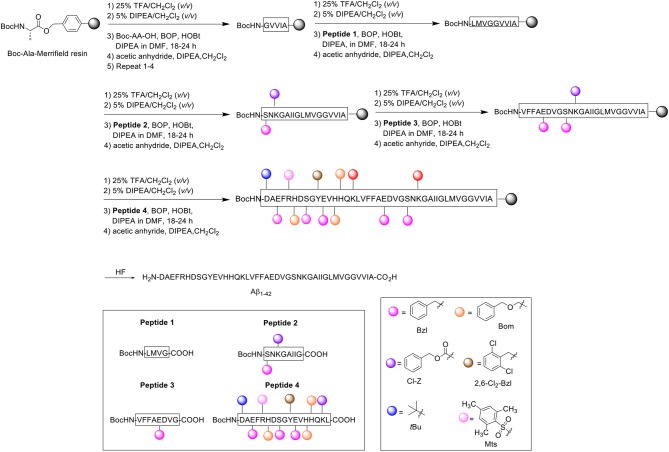
Boc/Bzl SPPS of Aβ1−42 by Hendrix et al. (1992).